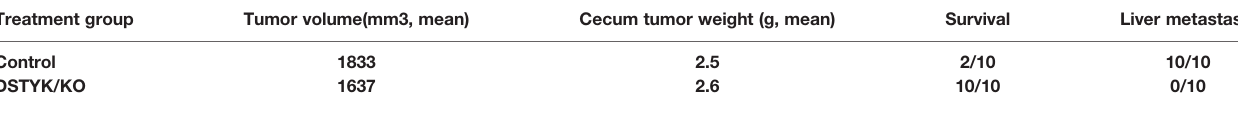
TABLE 1 | DSTYK regulates the metastasis of LS411N-T b RII cells implanted in the cecum of SCID mice. Treatment group Tumor volume(mm3, mean)